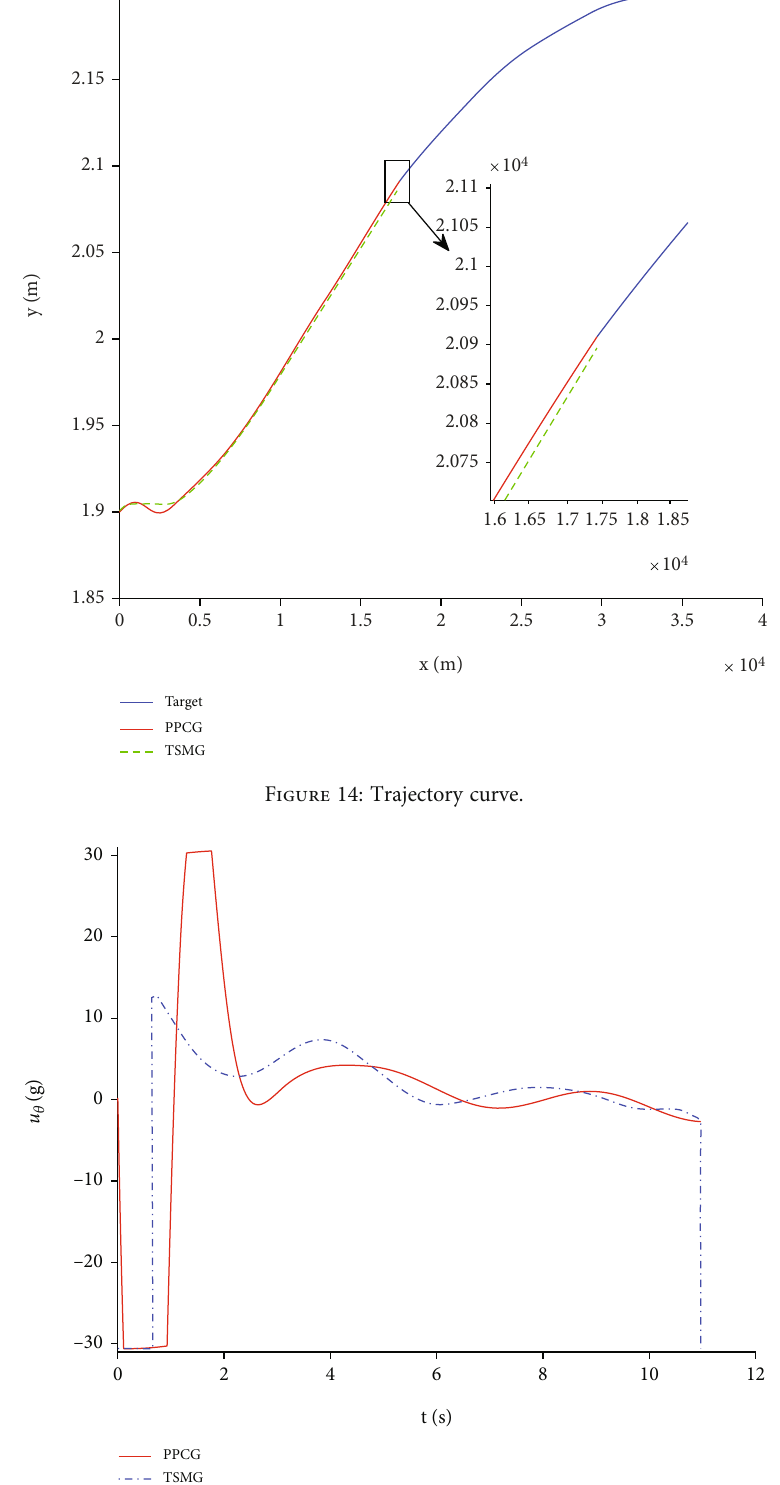
Figure 14: Trajectory curve.